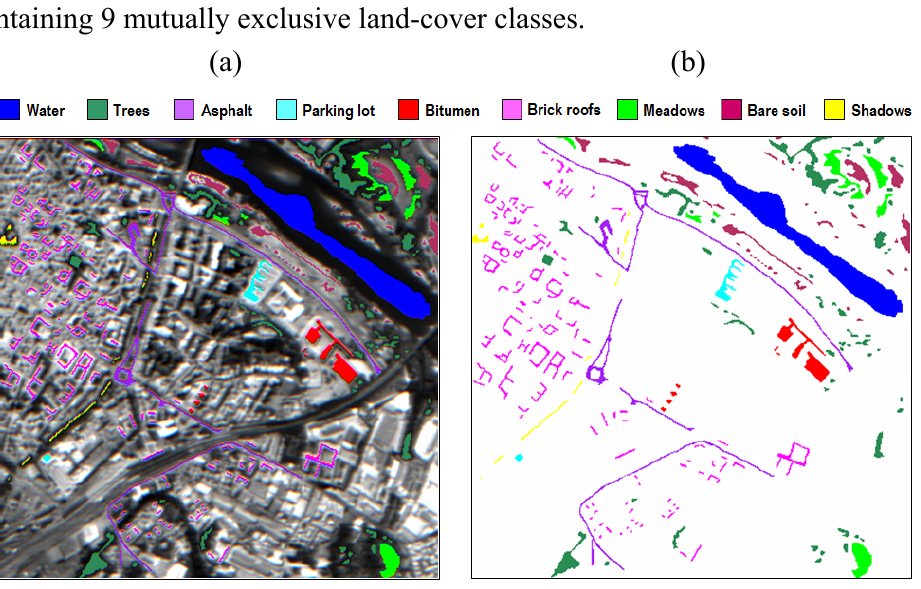
Figure 7. (a) Spectral band at 639 nm of a DAIS 7915 hyperspectral scene comprising urban features in Pavia, Italy, with ground-truth classes superimposed. (b) Ground-truth map containing 9 mutually exclusive land-cover